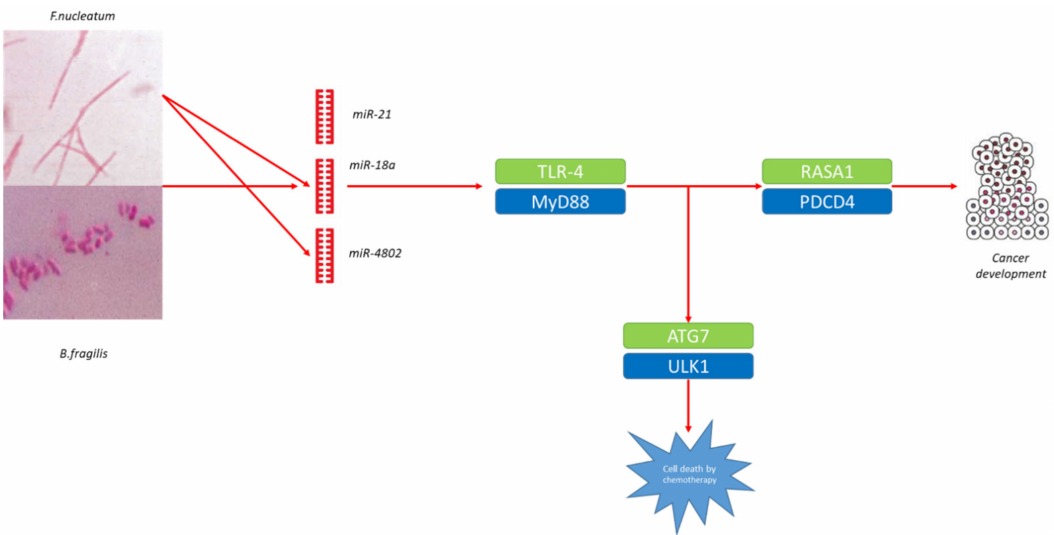
Figure 3. Example of the interaction between microbiome and microRNA in colorectal cancer. Fusobacteriumnucleatum and Bacteroidesfragilis areenrichedincancertissues. F.nucleatum increasescancer cell growth by upregulating miR-21 in cancer cells by stimulating the TLR4–MyD88 signalling, in turn bringing to a reduction the protein concentrations of RASA1 and PDCD4, which are cancer suppressor genes, leading to cancer development. In addition, F. nucleatum downregulates miR-18a and miR-4802, initiating TLR4–MyD88 activation and increasing ATG7 and ULK1, avoiding chemotherapy-caused programmed colorectal cell